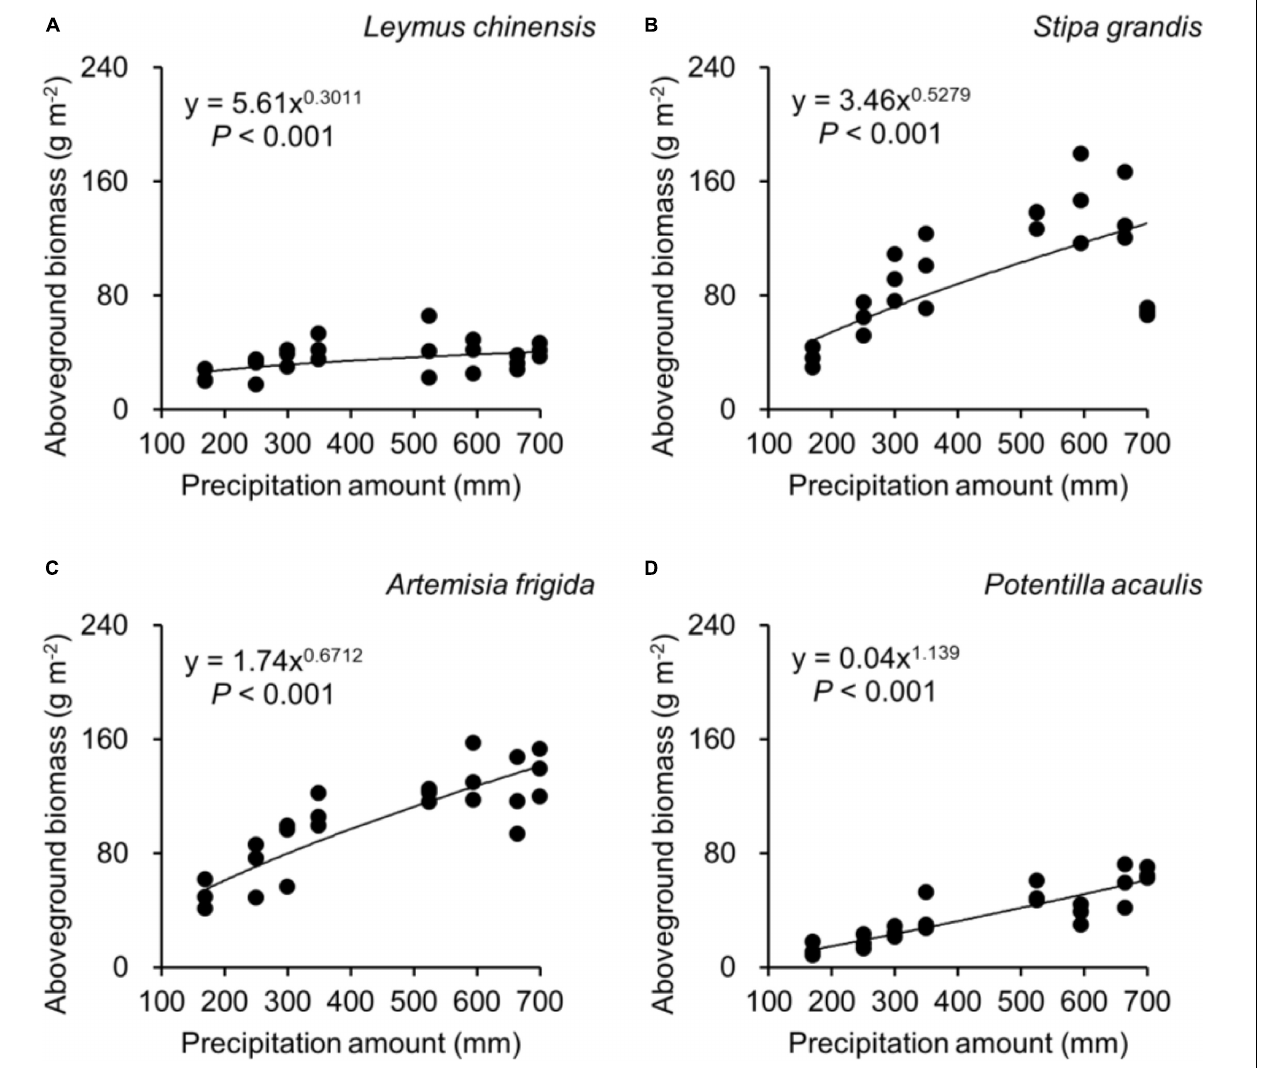
FIGURE 2 | At the pot scale, regressions between precipitation amount and aboveground biomass, separately for (A) Leymus chinensis , (B) Stipa grandis , (C) Artemisia frigida, and (D) Potentilla acaulis.